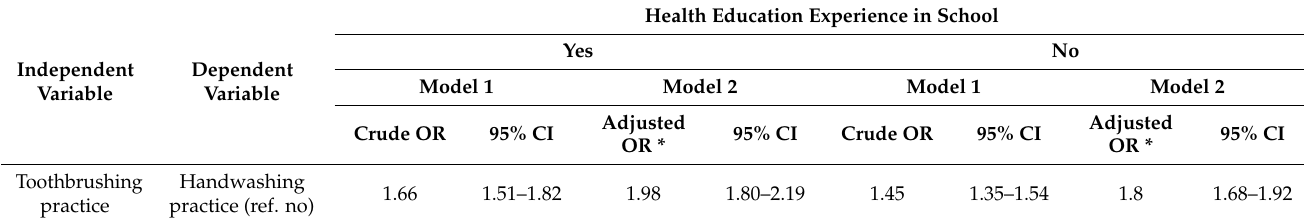
Table 4. Relationship between toothbrushing and handwashing stratified by students’ health education experience in school.